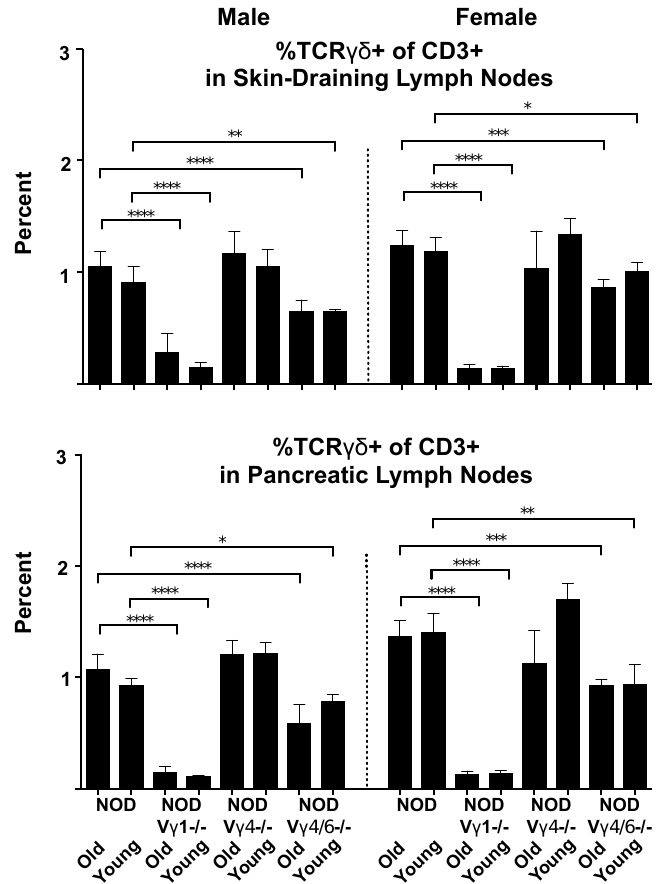
Figure 8. The γδ T cell percentage in skin draining and pancreatic lymph nodes of NOD-background γδ T cell subset-deficient vs. wt NOD mice. For each group, results of samples from 3–12 mice were analyzed. Results from skin-draining lymph nodes ( top ) and pancreatic lymph nodes ( bottom ) are shown. * p < 0.05, ** p < 0.01, *** p < 0.001, and **** p < 0.0001.